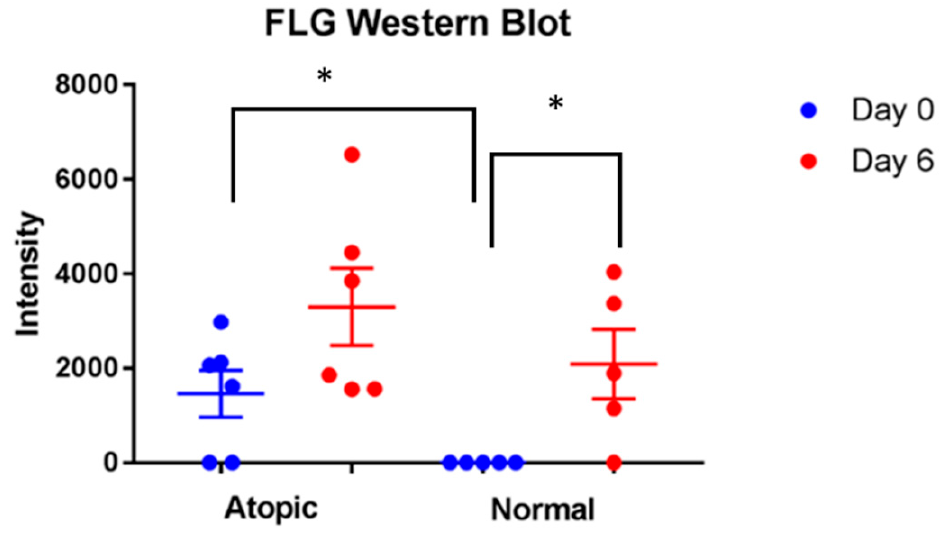
Figure 8. Significant increase of filaggrin was found in normal keratinocytes on D6 compared to D0 ( p = 0.046). Atopic keratinocytes had significantly higher amounts of filaggrin compared to normals on D0 ( p = 0.032). * indicates p < 0.05. For this analysis, five normal and six atopic cell cultures were used.